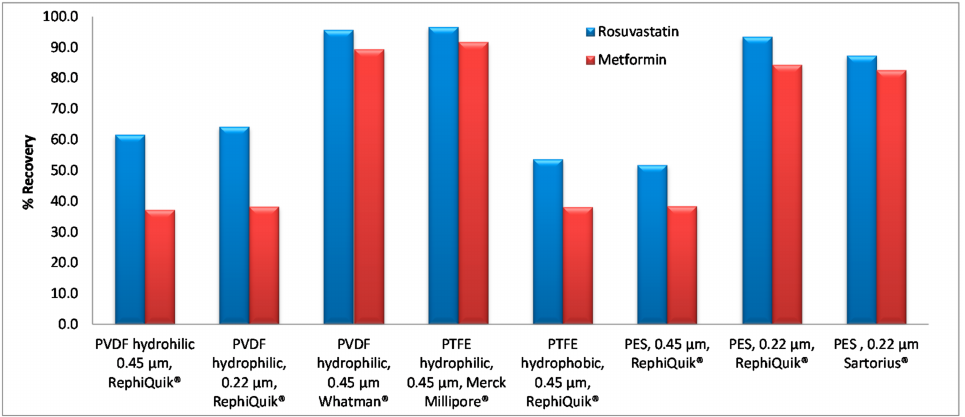
Figure 6. Effect of the type of the filters used for sample preparation of the biological samples on the % recovery of the